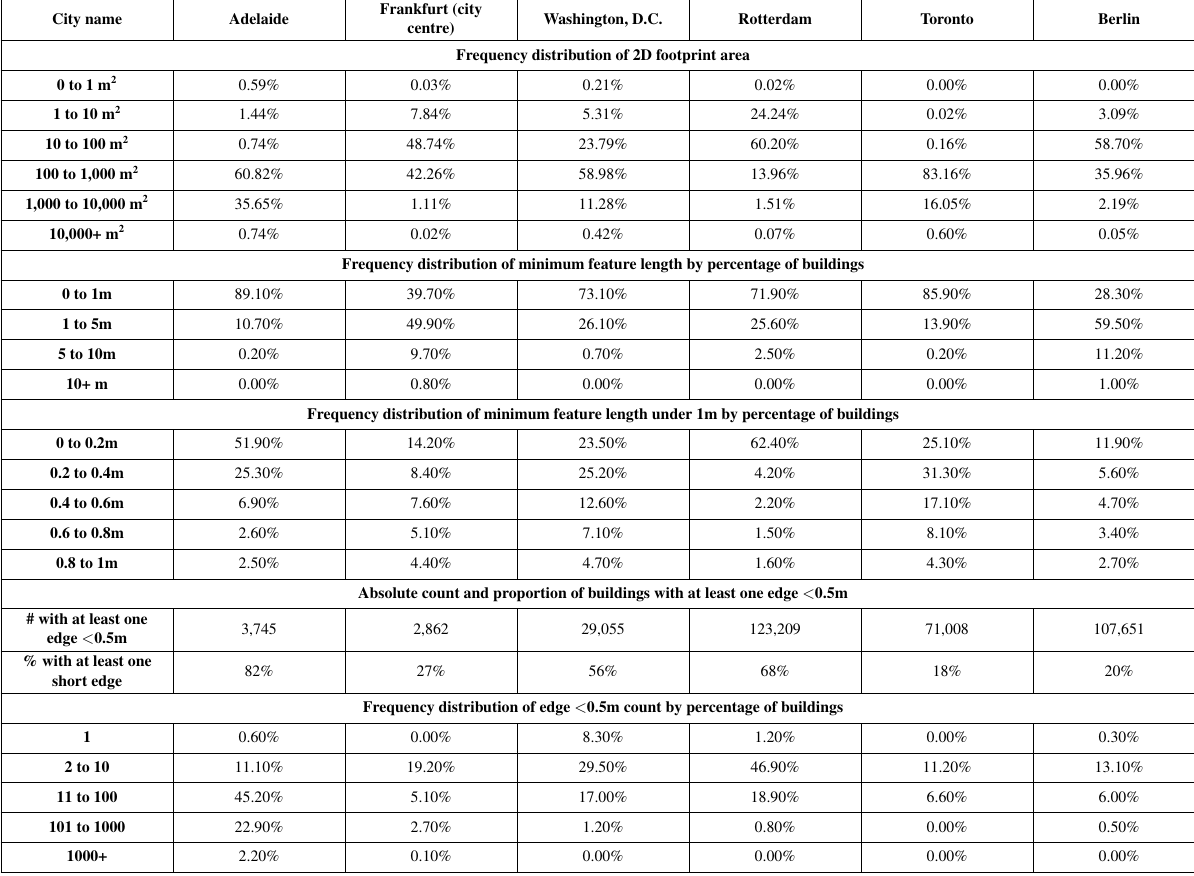
Table 2. Frequency distribution of the minimum size